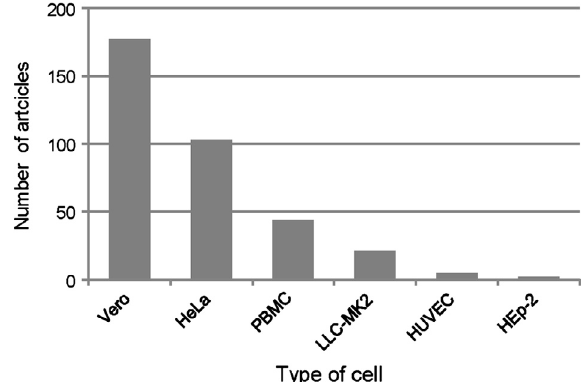
Figure 2. Number of articles found searching for Trypanosoma cruzi and specific cell lines in www.pubmed.org. Each bar represents the number of articles found until April 2013 when searching PubMed for: Vero, PBMCs (peripheral blood mononuclear cells), HeLa, LLC-MK2, HUVEC (human umbilical vein endothelial cells), and HEp-2 (HeLa